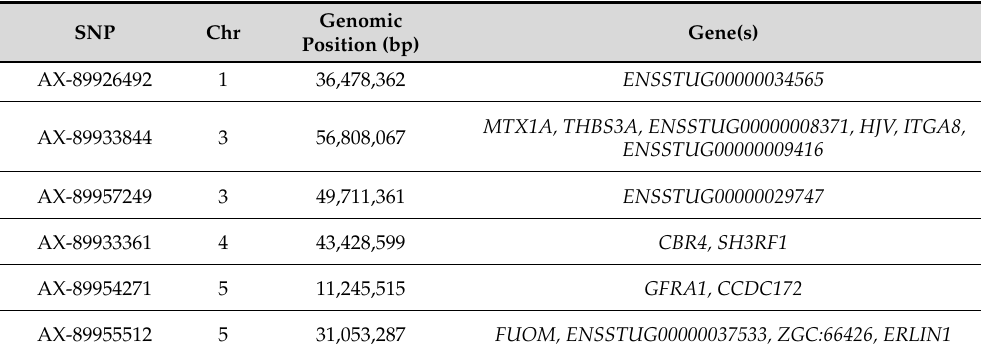
Figure 4. Distribution on the 40 trout chromosomes of the SNPs selected for the 96 SNP panels using the four different methods described in this study (RF GI 1 = random forest Gini Index stability occurrence; RF GI 2 = random forest Gini Index stability mean; RF EN 1 = random forest Entropy stability occurrence; RF EN 2 = random forest Entropy stability mean; Delta; F ST = Fixation index; PCA = principal component analysis). Table 4. List of genes pinpointed by VEP tool within or close (<50 Kbps) to common SNPs included in the panels selected by the seven different methods used in this study (RF GI1, RF GI2, RF EN1, RF EN2, Delta, F ST and